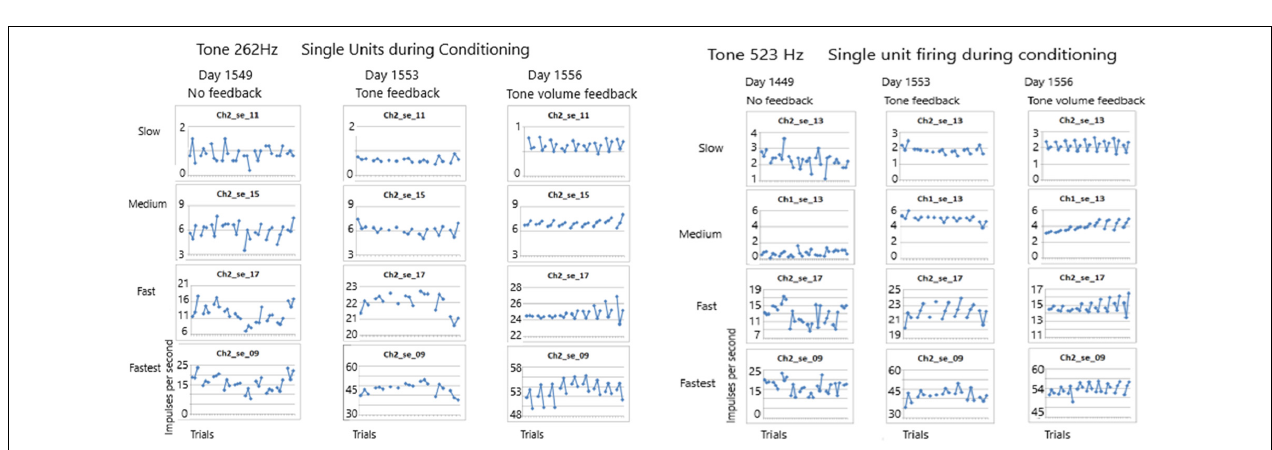
FIGURE 7 | Firing rates of SUs are shown over seven to ten trials for tones of 262 and 523 Hz. Each trial plots the firing rate during listening, resting and silent singing. On day 1549 no feedback was provided during silent singing. On day 1553 feedback of the tone was triggered by firing of SU 2-17. On day 1556, the volume of the tone feedback was increased proportionate to the rate of firing. The conditioning improved across the three sessions.